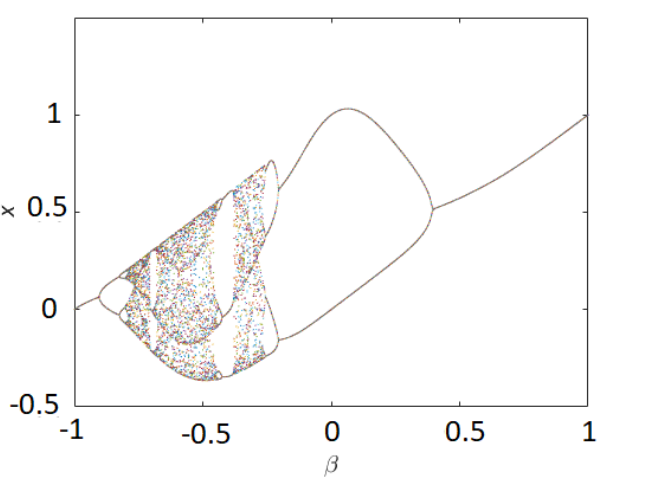
Figure 1. Bifurcation diagram of Gauss map.